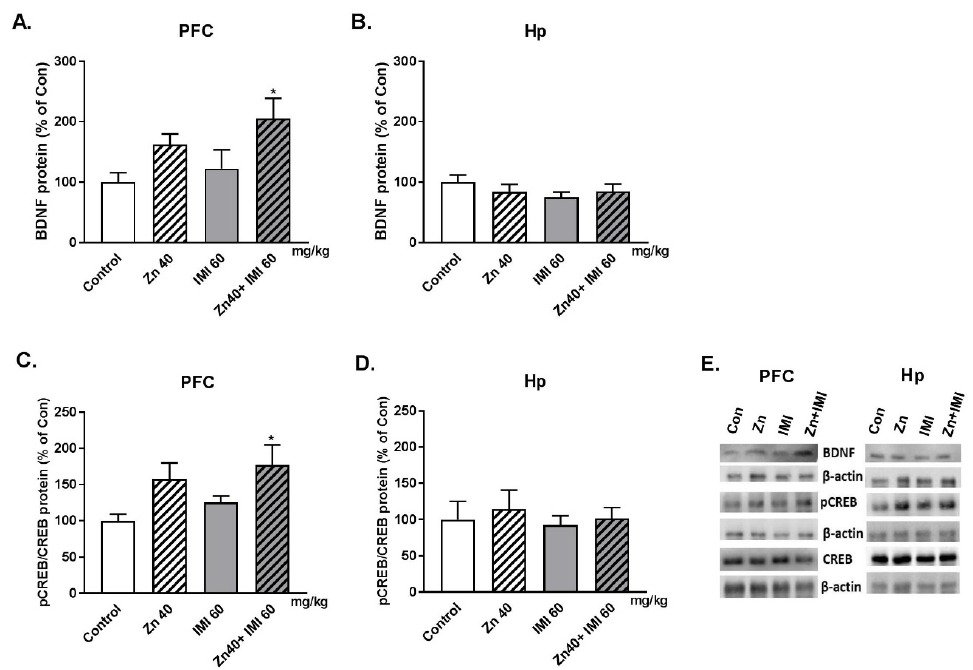
Figure 2. Western blot analysis of the e ff ect of Zn (40 mg Zn / kg) + IMI (60 mg / kg), and NaCl (control) administered p.o. on the protein levels of BDNF ( A , B ) and p-CREB / CREB ( C , D ) in the PFC and Hp of mouse. Results are expressed as mean ± S.E.M (n = 5–7 per group). * p < 0.05 vs. control group (two-way ANOVA followed by Tukey post-hoc test) ( E